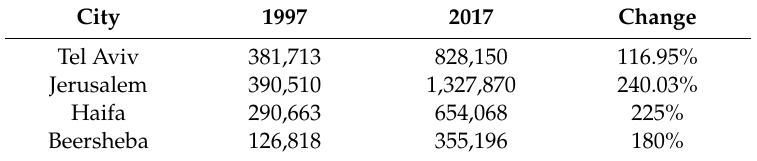
Table 5. Residential revenue property tax (NIS thousands) between 1997 and